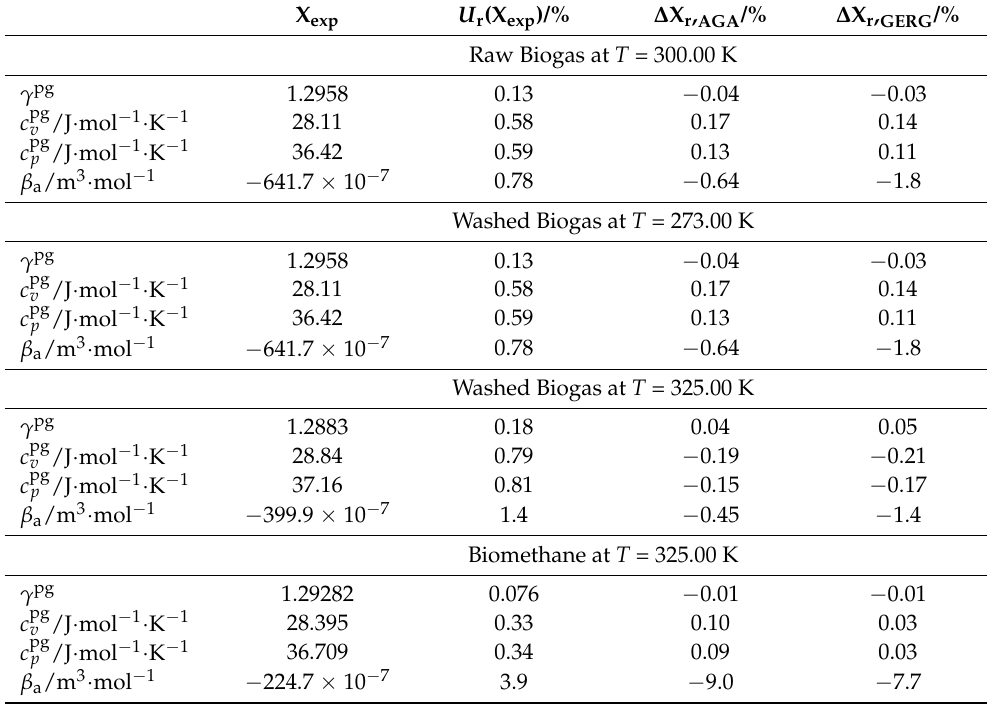
Table 3. Perfect gas–heat capacity ratio ( γ pg ), perfect gas–heat capacities at constant volume ( c pg v ) and at constant pressure ( c pg p ), and second virial acoustic coefficients ( β a ) of the three biogas mixtures with their corresponding relative expanded ( k = 2) uncertainties and relative deviations of these properties ( ∆ X r , EoS = (X exp − X EoS )/X EoS ) from the predicted values with AGA8-DC92 and GERG- 2008 equations of state. X exp U r (X exp )/% ∆ X r , AGA /%